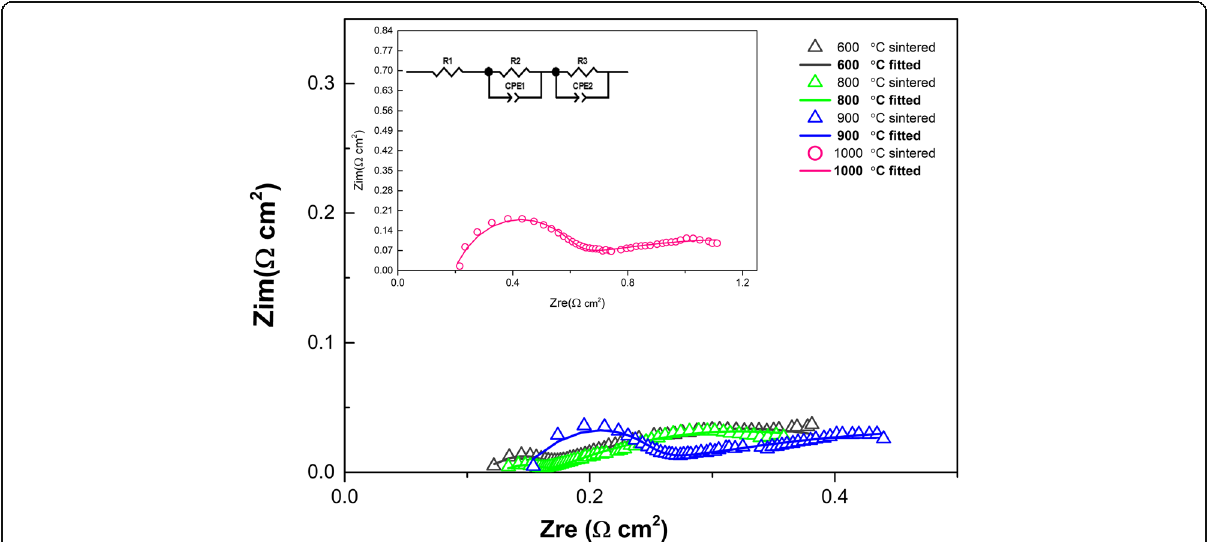
Fig. 5 Impedance spectra of the LSCF-SCDC fuel cells with various sintered temperatures, tested in H 2 /air atmosphere at 550 °C. Point: primary Nyquist plots; Line: fitting Nyquist plots